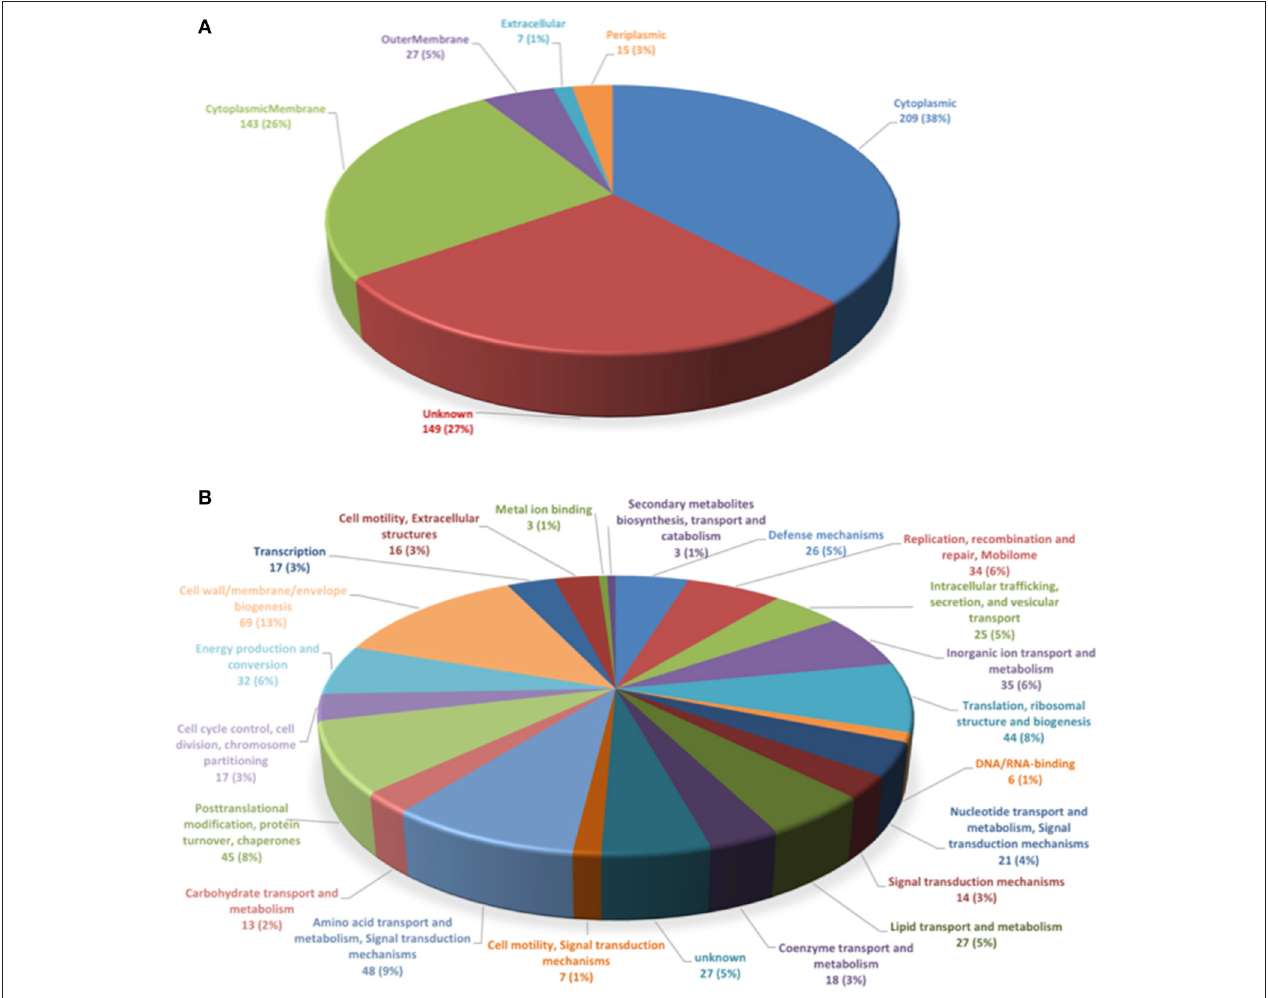
FIGURE 1 | Classification of P. salmonis LF-89 membrane vesicles proteins. (A) Subcellular locations of membrane vesicle proteins identified by MudPIT. Predicted subcellular locations of the 452 membrane vesicle proteins identified using PSORT3b. (B) Functional classification of P. salmonis LF-89 membrane vesicles proteins. The 452 proteins identified by MudPIT were sorted according to the indicated clusters of orthologous